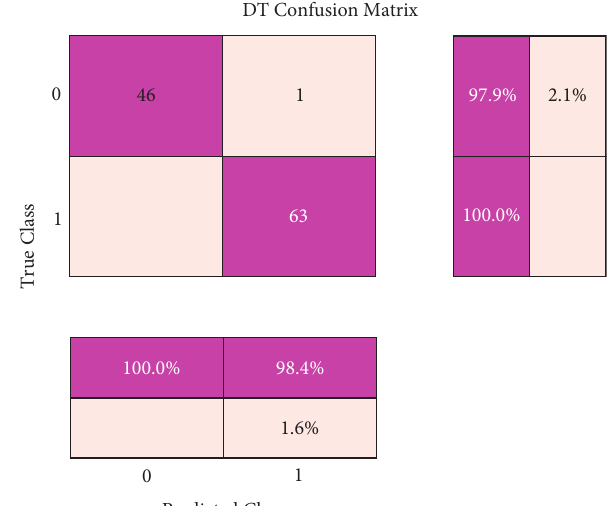
Figure 8: Confusion matrix of LDA and NB methods.